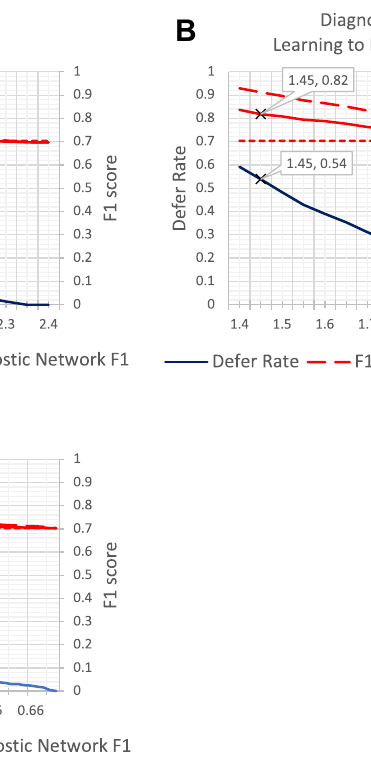
Figure 3. Performance comparison for the diagnosis of any comorbidities (identified by positive Charlson index) using the Heritage Health dataset and the following algorithms: (A) learning to defer with Uncertainty (LDU), (B) learning to defer without uncertainty information (LD), (3) direct triage by uncertainty (DT). Each panel shows the F1 scores (red line) for patients who are not deferred to human experts, ‘F1 Overall’ scores (red dashed line) and the corresponding defer rates (blue line) for different values of the weight of the defer loss α ( A,B ) or of the entropy threshold ( C ). The diagnostic network F1 score (without the defer option) is 0.70 (red dotted